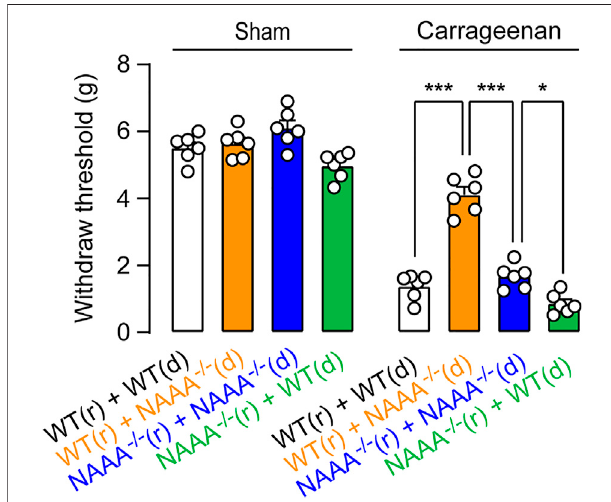
FIGURE 6 | Genetic blockade of NAAA in non-BM cells cause analgesic tolerance. BM isolated from WT (d) or NAAA -/- (d) mice was individually transferred into lethally irradiated WT (r) or NAAA -/- (r) mice. Chimeras were used for behavior studies 8 weeks after initial reconstitution. Chimeric mice were intra-plantar injected with 1% λ -carrageenan or saline vehicle. Hyperalgesia was measured at 6 h after carrageenan or saline vehicle injection.Dataareexpressedasmean ± SEM( n (cid:1) 5).*, p < 0.05;***, p < 0.001 by one-way